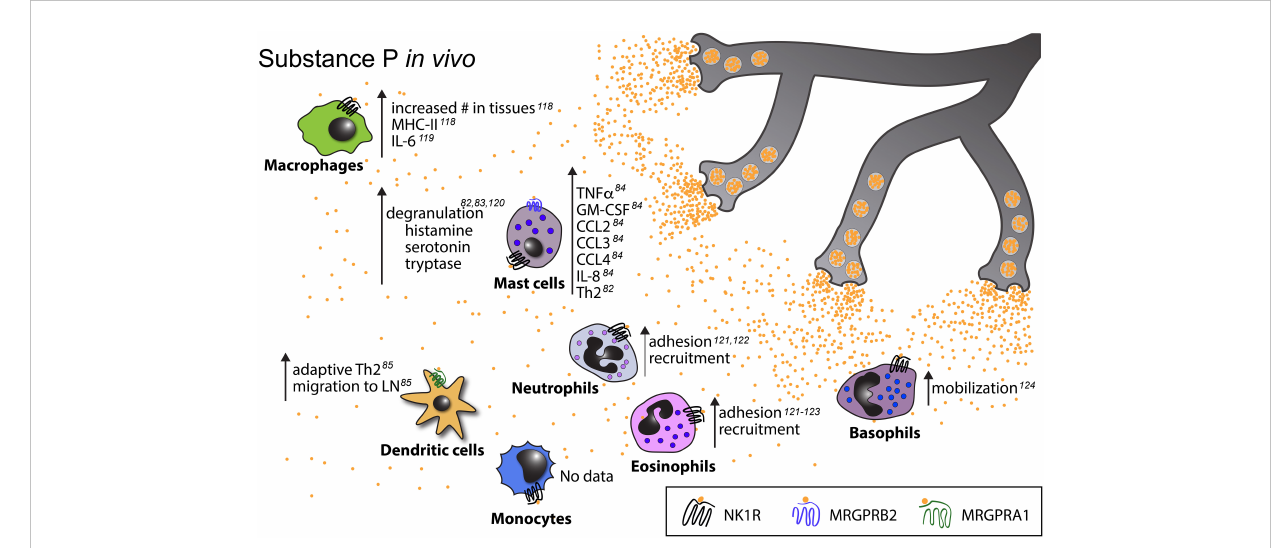
FIGURE 3 Known in vivo effects of substance P on myeloid cells. Upward pointing arrows signify upregulation/activation, downward facing arrows signify